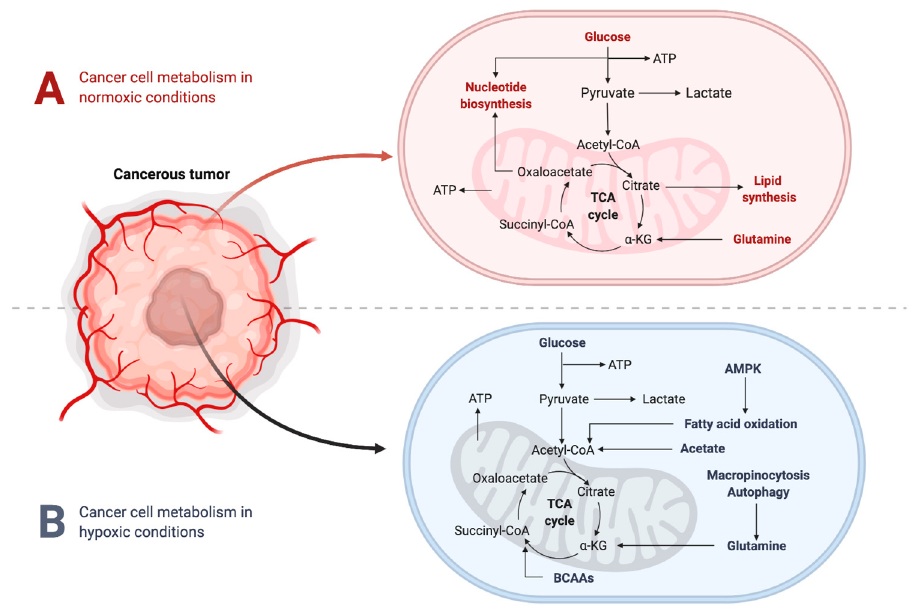
Figure 3. Cancer cell metabolism under hypoxic and normoxic conditions.